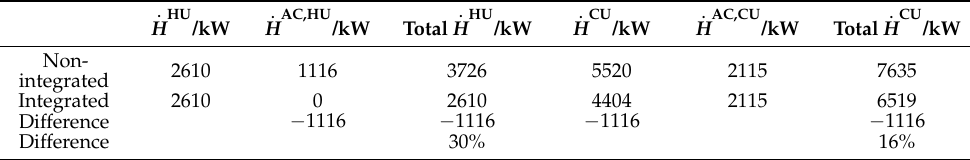
Table 4. Comparison of integrated and non-integrated solution for case study 1.